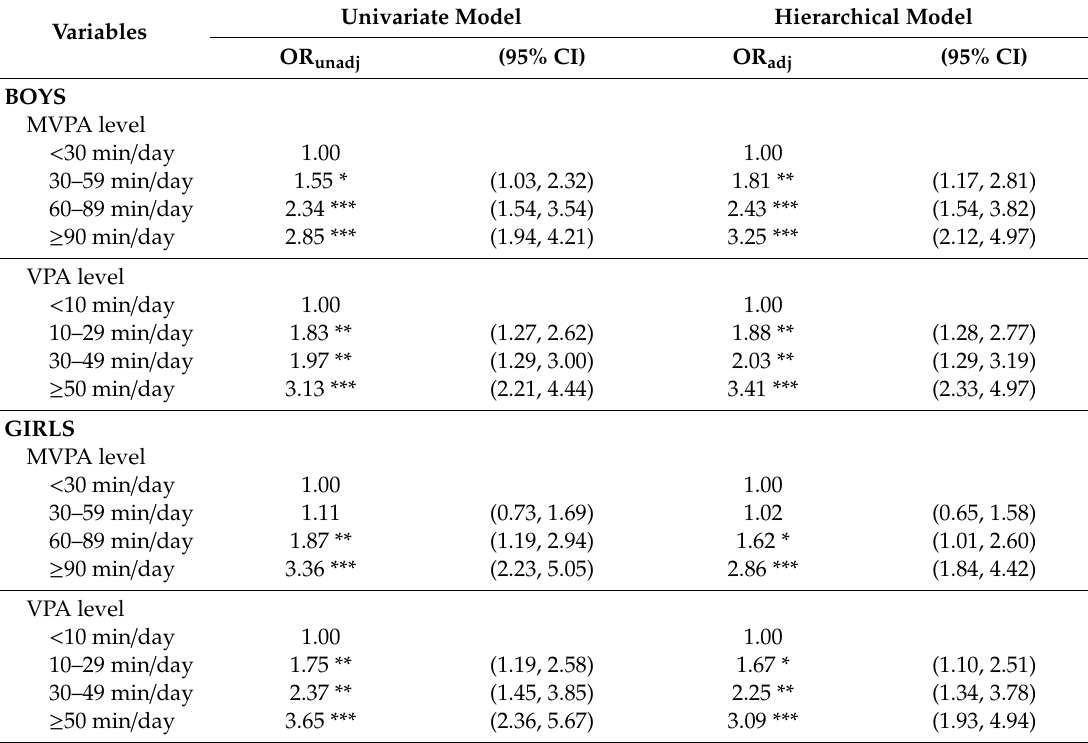
Table 4. Risk estimates of PA levels for PARIs by